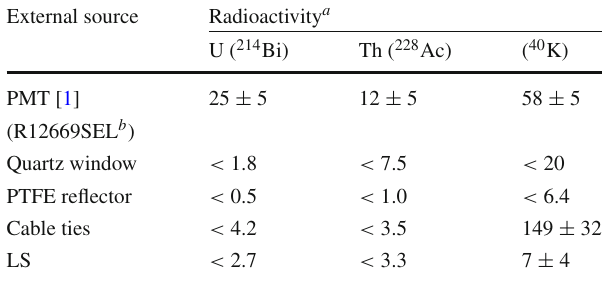
Table 2 Radioactivity levels in detector components inside the shield- ing.(a)TheradioactivitiesweremeasuredwithaHPGedetectoratY2L; upper limits are quoted with 90% C.L. The PMTs are measured in units of mBq/PMT and the other external sources are measured in units of mBq/kg (b) SEL means “selected for high quantum efficiency”